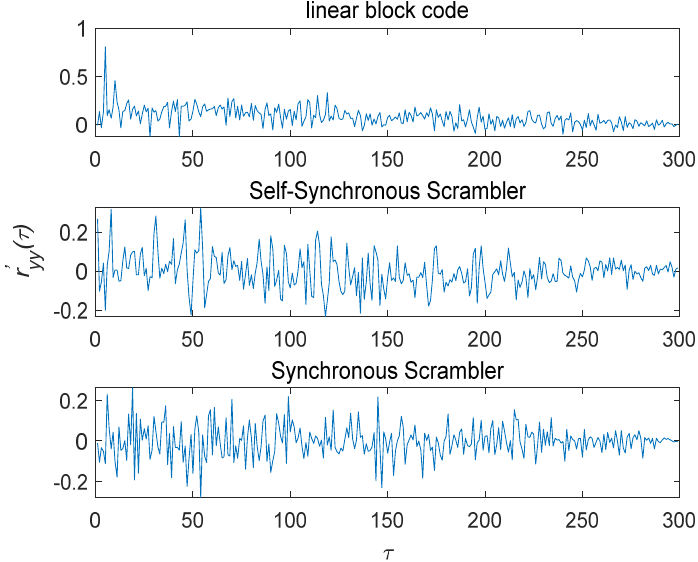
Figure 5. Normalized partial autocorrelation function diagram when SNR = 6 dB.